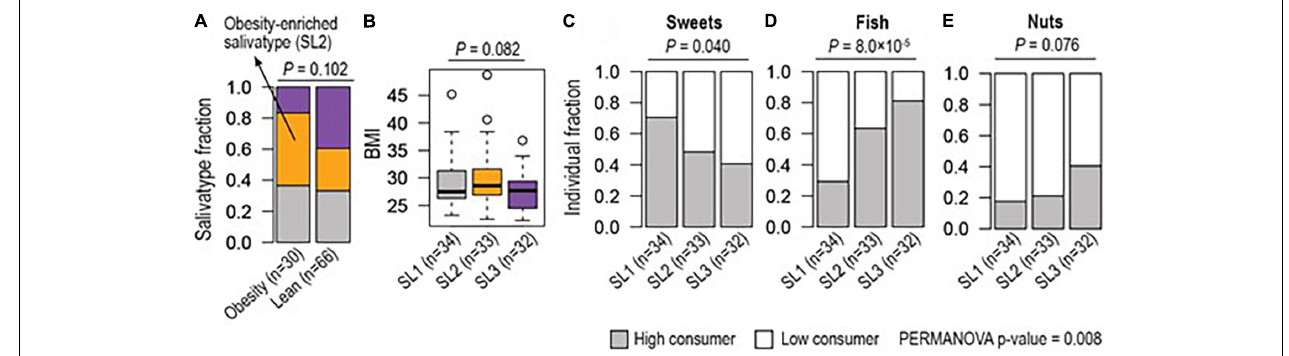
FIGURE 4 | Different enrichment of salivatype (SL) in obesity and in relation to consumption of food groups. (A) Salivatype-2 was enriched among obese ( ≥ 30 BMI) subjects compared to lean ( < 25 BMI) subjects (Chi-square test p -value = 0.102). (B) Salivatype-2 was associated with a high median BMI (ANOVA p -value = 0.082). Together, (C) sweet snacks, (D) fish, and (E) nuts were differently consumed among subjects with different salivatypes (Chi-square tests, p -values < 0.1) and their coordinate changes were associated with salivatypes (PERMANOVA p -value =